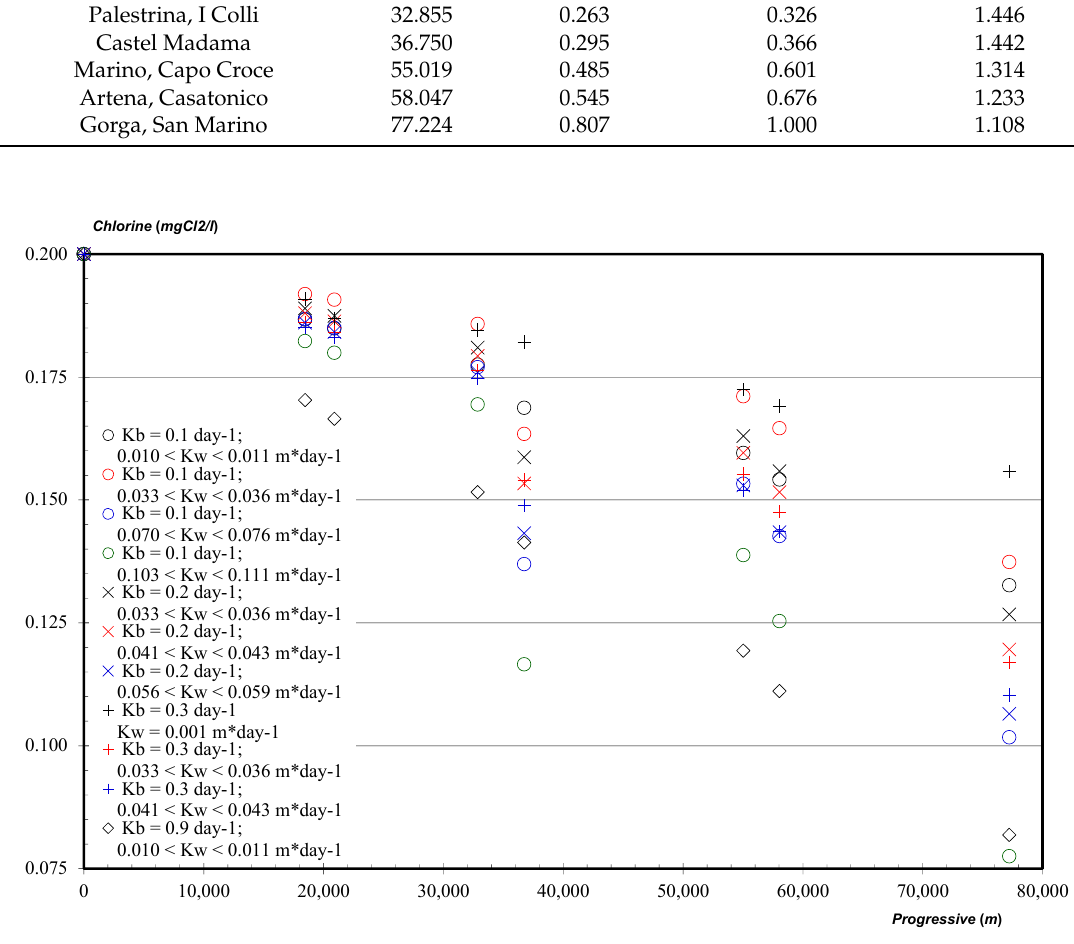
Figure 6. Comparison between calculated values and statistical parameters of the observed data.